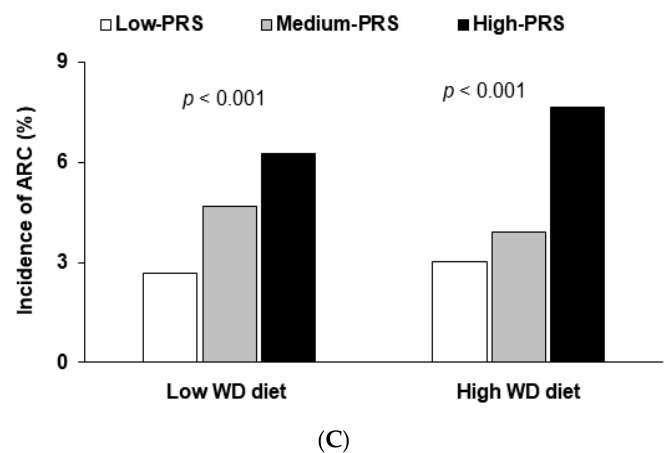
Figure 3. Prevalence of age-related cataracts (ARC) in participants in the low-, medium- and high-PRS groups (defined using the 6 SNP genetic variant–genetic variant interaction model): ( A ) In the participants according to the Na intake (cutoff point: 1600 mg/1000 kcal; ( B ) In the participants according to the coffee intake (cutoff point: ≥ 3 g/day); ( C ) In the participants according to the consumption of a Western-style diet pattern (WD; cutoff point: 70th percentile). PRS was calculated by the summation of polygenetic-risk scores of the best model with 6 SNPs and categorized into three groups (0–6, 7–9, and ≥ 10) by the tertiles (low-PRS, medium-PRS, and high-PRS). p -value represented the significant differences among the PRS groups by χ 2 test in each category.